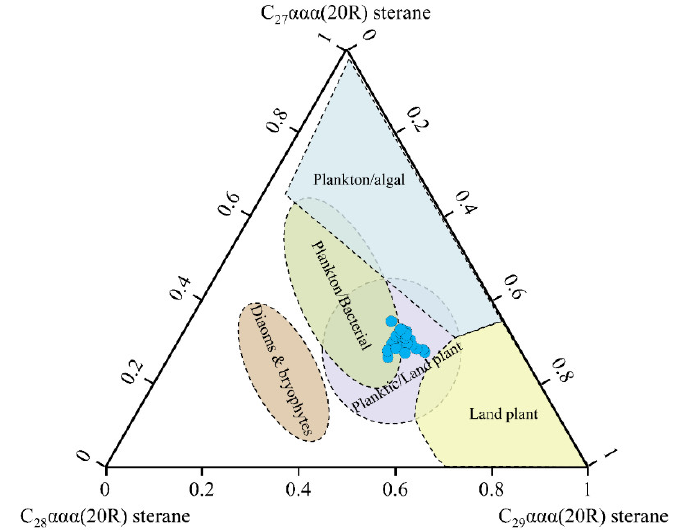
Figure 8. Ternary diagram of C 27 , C 28 , and C 29 regular steranes showing the relationship between sterane composition and organic matter inputs for the Qingshankou lacustrine shales.